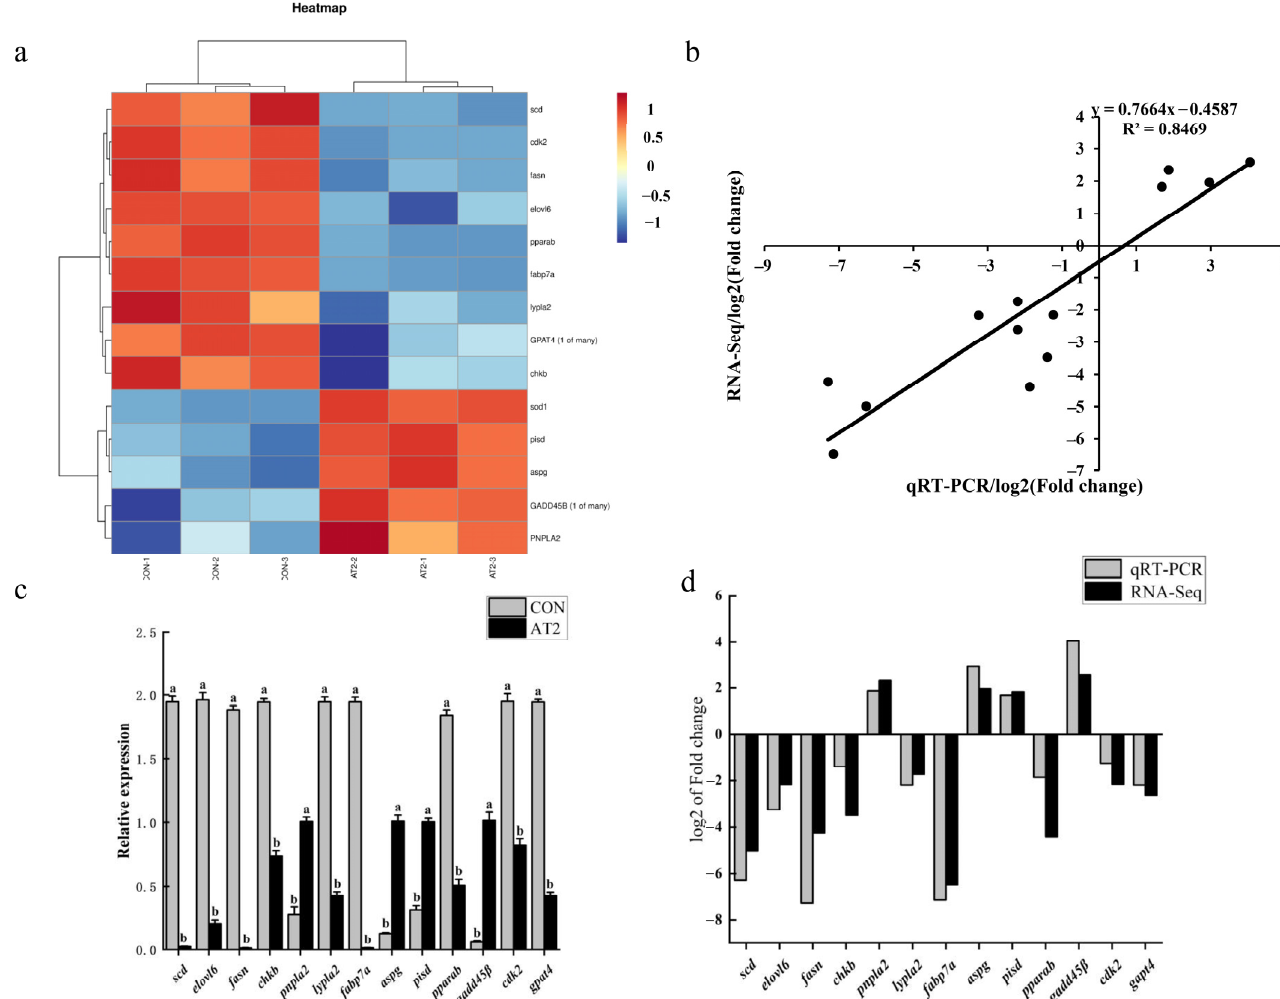
Figure 6. Overview of important DEGs in Nile tilapia. ( a ) Heat map of 14 selected DEGs in CON (control group) and AT2 (AGPAT2 knock-down group) (criteria for identification of DEGs: |log2 fold change| ≥ 1 and p < 0.05). Highly expressed genes are shown in red; genes expressed at low levels are shown in dark blue; ( b ) correlation analysis between RNA-Seq and qRT-PCR validation results of 13 genes; ( c ) transcript levels of DEGs ( n = 9 replicates) in CON (control group) and AT2 (AGPAT2 knock-down group); ( d ) comparison of transcriptome data and qRT-PCR data. Different letters indicate significant differences ( p < 0.05) between the two groups.